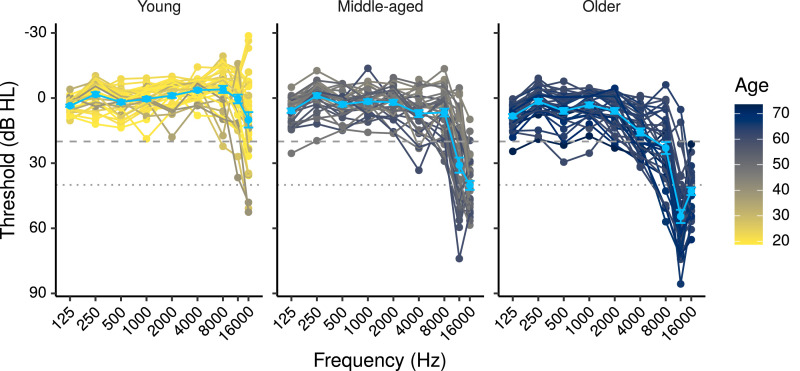
Audiometric thresholds for the study participants. The light blue points plot mean thresholds  ±  1 standard error of the mean (s.e.m.) for each age group. The dashed and dotted lines mark respectively 20, and 40 dB HL.